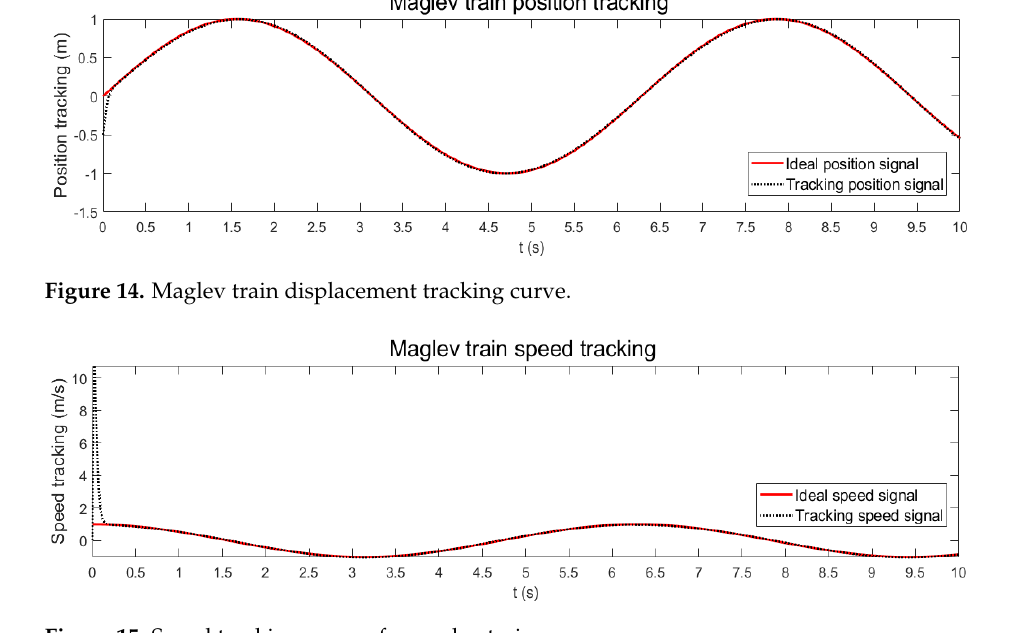
Figure 15. Speed tracking curve of a maglev train.